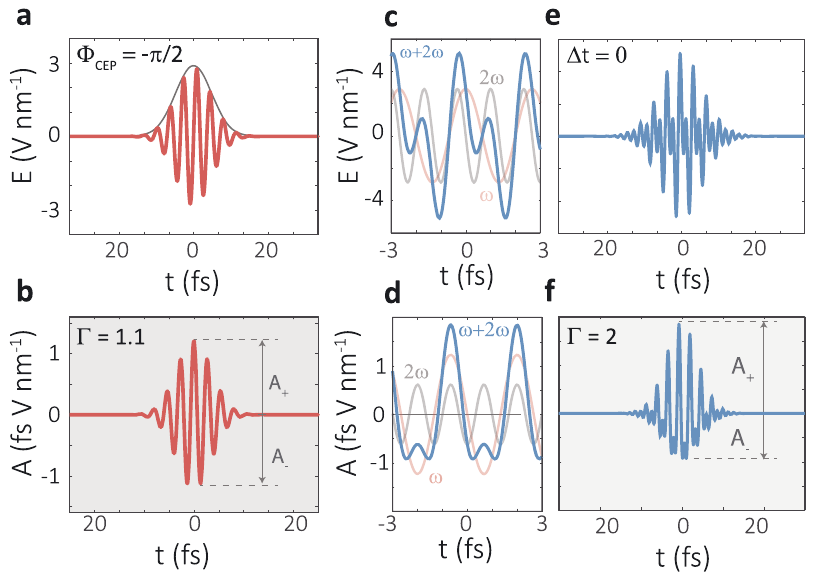
Figure 1: Electric field and vector potential waveform of a single and a two-color laser field. The top panels show the electric field waveform (a, c, and e), with the corresponding vector potential in (b, d, and f). (a) Gaussian electric field waveform for a 5.4 fs laser pulse oscillating at 𝜔 = 2 𝜋 ⋅ 375 THz and an electric field amplitude of 3 V/nm. The carrier-envelope phase is set to Φ = − 𝜋 ∕ 2. (b) Corresponding vector CEP = − 𝜋 ∕ 2 the vector potential exhibits a clear peak toward positive values, i.e., | A | > | A | . The asymmetry parameter Γ potential. For Φ + − CEP (see Eq. (2)) is 1.1. (c) Two-color electric field, shown in case of a continuous wave (red: 𝜔 and blue: 2 𝜔 ), with the corresponding vector potential in (d). When both pulses are phase-shifted by 𝜋 ∕ 2 and the electric field strengths of the 𝜔 - and 2 𝜔 -pulse are equal (corresponding to a 2:1 ratio in A ( t )), the vector potential has its maximal asymmetry with respect to A + and A − ( Γ = 2). (e) The two-color electric field with = 0, while the 2 𝜔 pulse has a pulse duration of 8 fs, a the same field strengths and pulse duration as for the 𝜔 -pulse shown in (a) and a Φ CEP = 𝜋 ∕ 2. These parameters are chosen to visualize the strongly asymmetric vector potential, i.e., Γ = 2 field strength of 3 V/nm and Φ CEP shown in